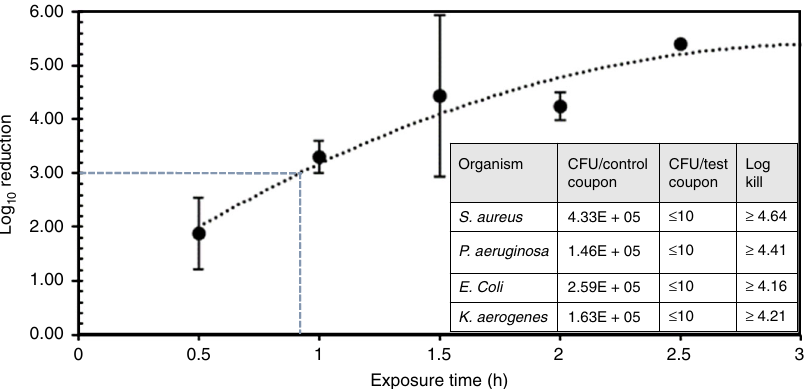
Fig. 4 Bacterial reduction kinetics on paint coupons containing copper glass ceramic particles. Plot of S. aureus reduction as a function of exposure time shows a steady decrease in S. aureus colony counts over 2.5 h, at which point bacterial colonies reduced down to limit of detection. EPA-prescribed 3-log kill (99.9% reduction) was observed in about 1 h. Data and error bars represent mean and standard deviation from two experiments with samples in triplicate. The inset table showcases the high bactericidal ef fi cacy of copper – glass ceramic particles against S. aureus , P. aeruginosa , E. coli and K. aerogenes. ≥ 4-log kill ( ≥ 99.99% reduction) was measured against all bacteria following 2-h exposure to test coupons. Bacterial growth on each test and control coupon was measured in triplicate — data shown are geometric mean of values